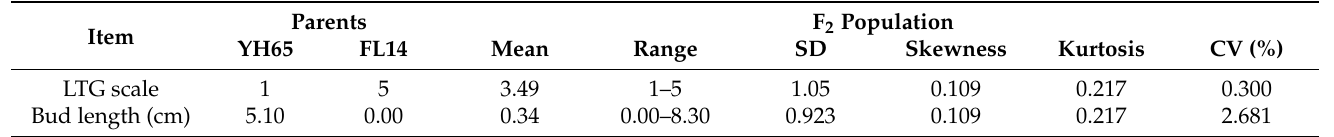
Table 1. Phenotypic variation analysis of parents and F 2 population.